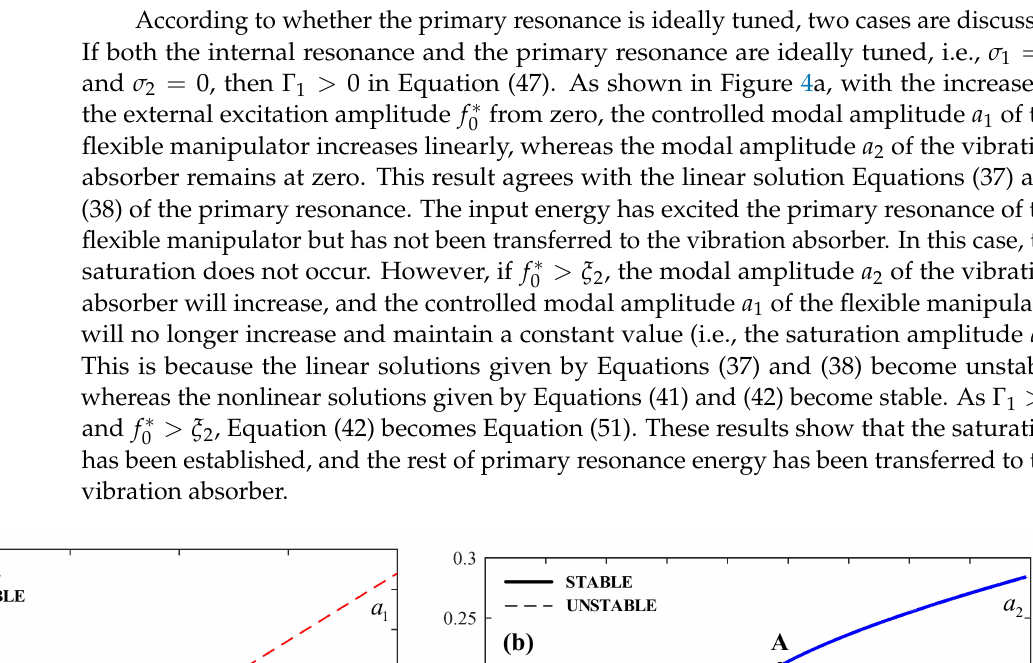
on modal amplitude: ( a ) condition: σ 1 = 0, σ 2 = 0; 0